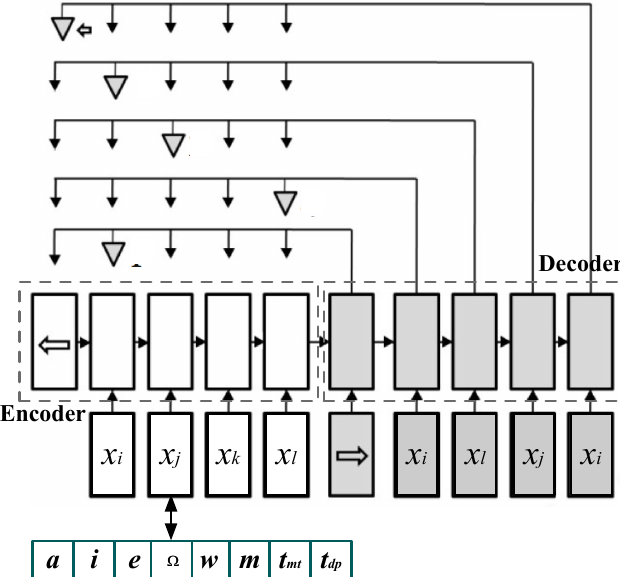
Figure 7. Improved pointer network with dynamic